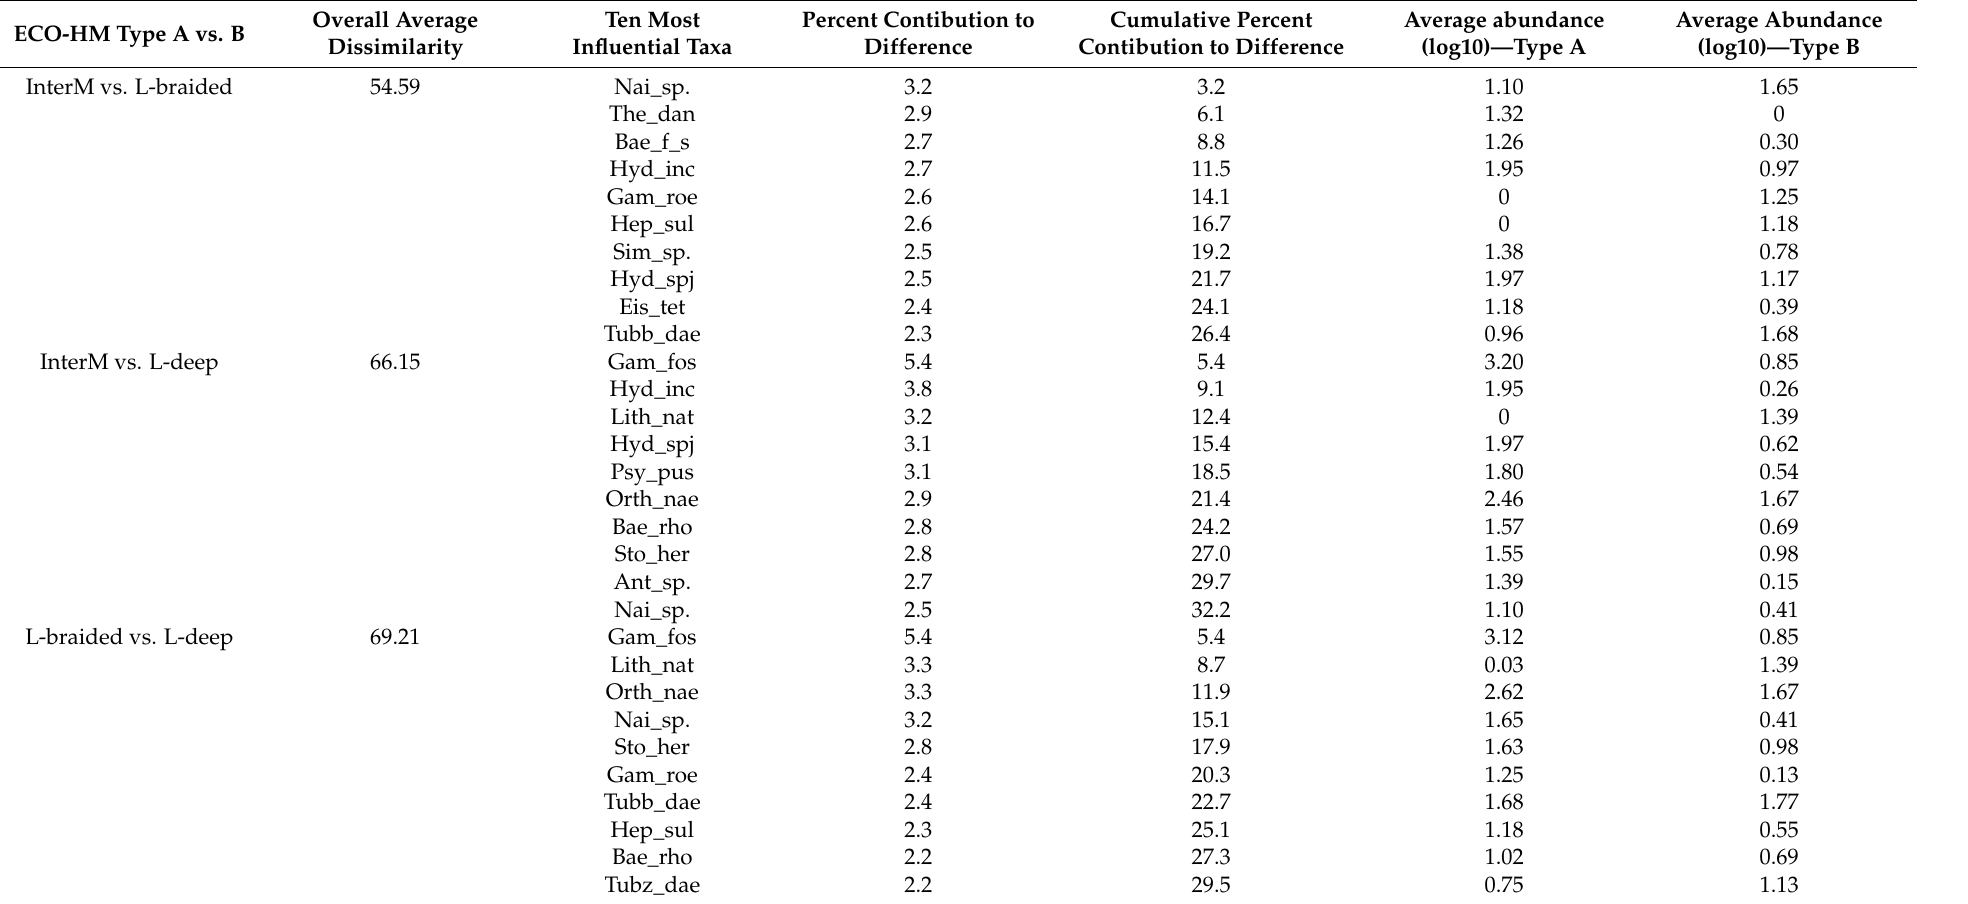
Table 4. Results of SIMPER analyses indicating the contribution of benthic invertebrate taxa to the observed differences between benthic invertebrate assemblages of eco-hydromorphological (ECO-HM) types. Only taxa found in at least five samples were considered. Abbreviations refer to the ECO-HM types sampled: InterM—intermountain, L-braided—lowland-braided, L-deep—lowland-deep. For taxon abbreviations, see Appendix